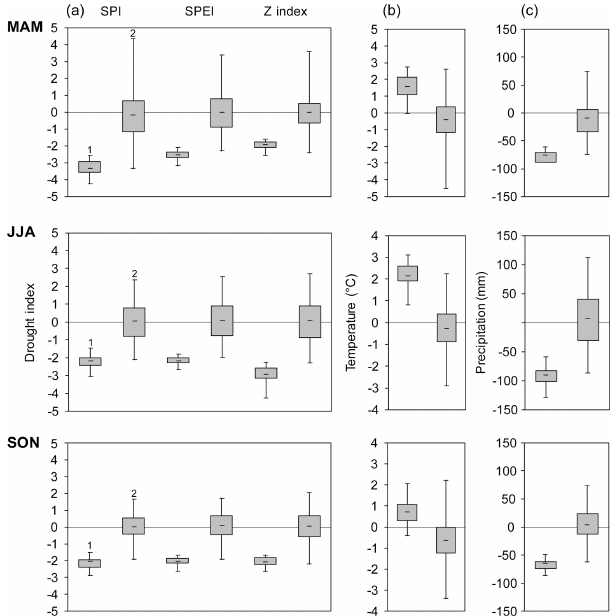
Figure 2. Fluctuations in JJA SPI, JJA SPEI and JJA Z index in the Czech Lands in the 1501–2017 period. Coloured horizontal lines mark the limits for estimation of extreme droughts with return peri- ods of N = 10, 20, 50, 100 and 200 years.